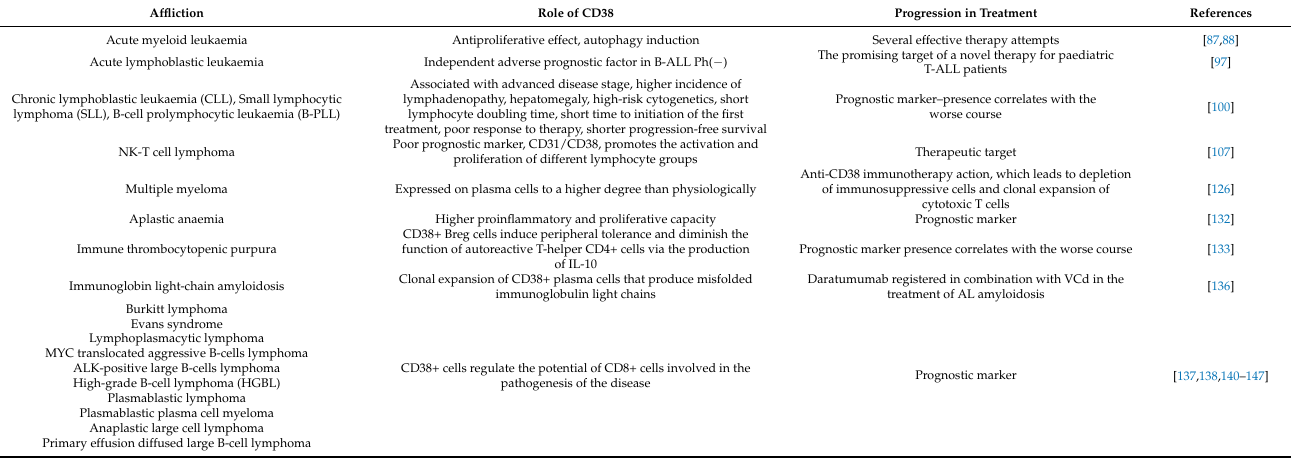
Table 2. Hematological diseases involving the role of CD38 in the